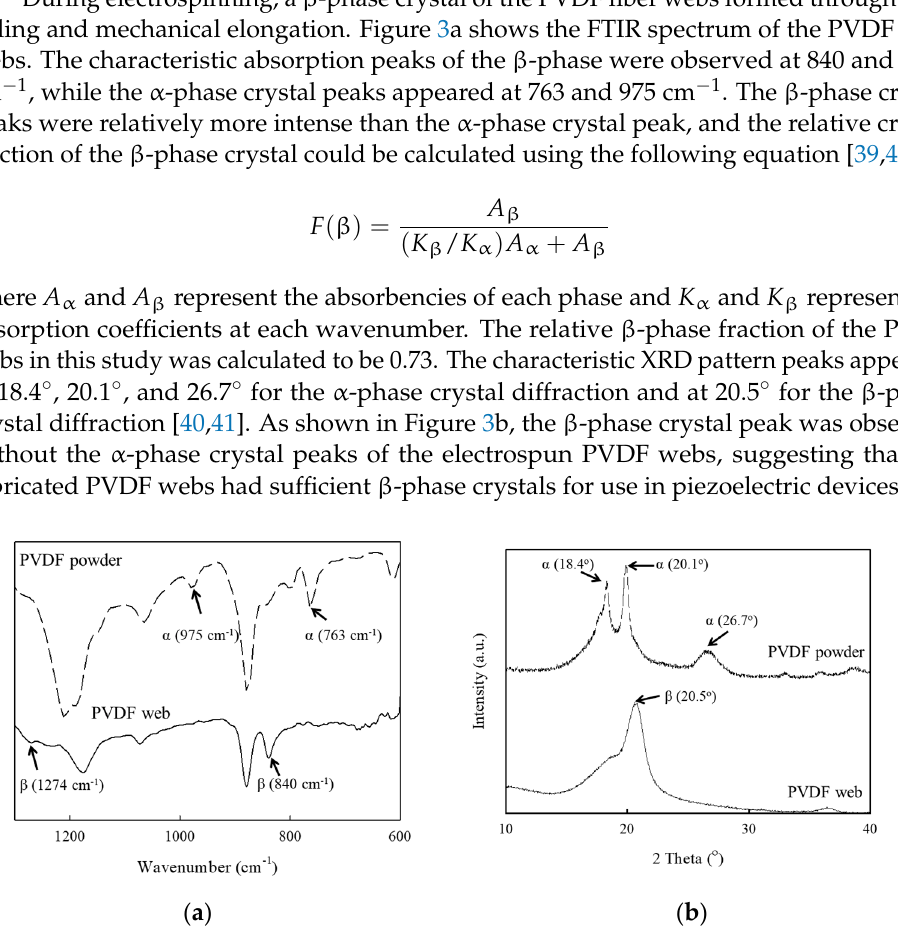
Figure 2. ( a ) FE-SEM image of the PVDF webs before and ( b ) after dip-coating. ( c ) Fiber diameter distribution.